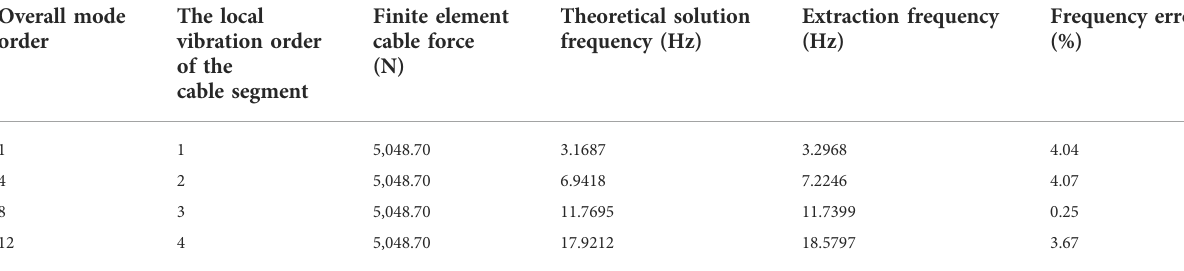
TABLE 3 Comparison of extraction frequency and theoretical frequency. Overall mode order